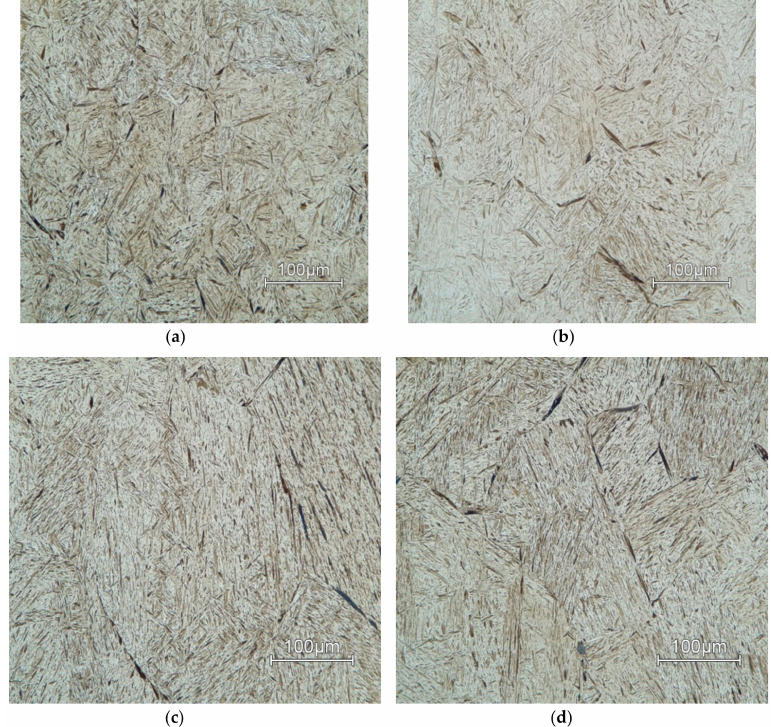
Figure 18. Microstructure of samples deformed at temperature of T = 1200 ◦ C at strain rate: ( a ) 1 s − 1 ; ( b ) 0.1 s − 1 ; ( c ) 0.01 s − 1 ; ( d ) 0.001 s − 1